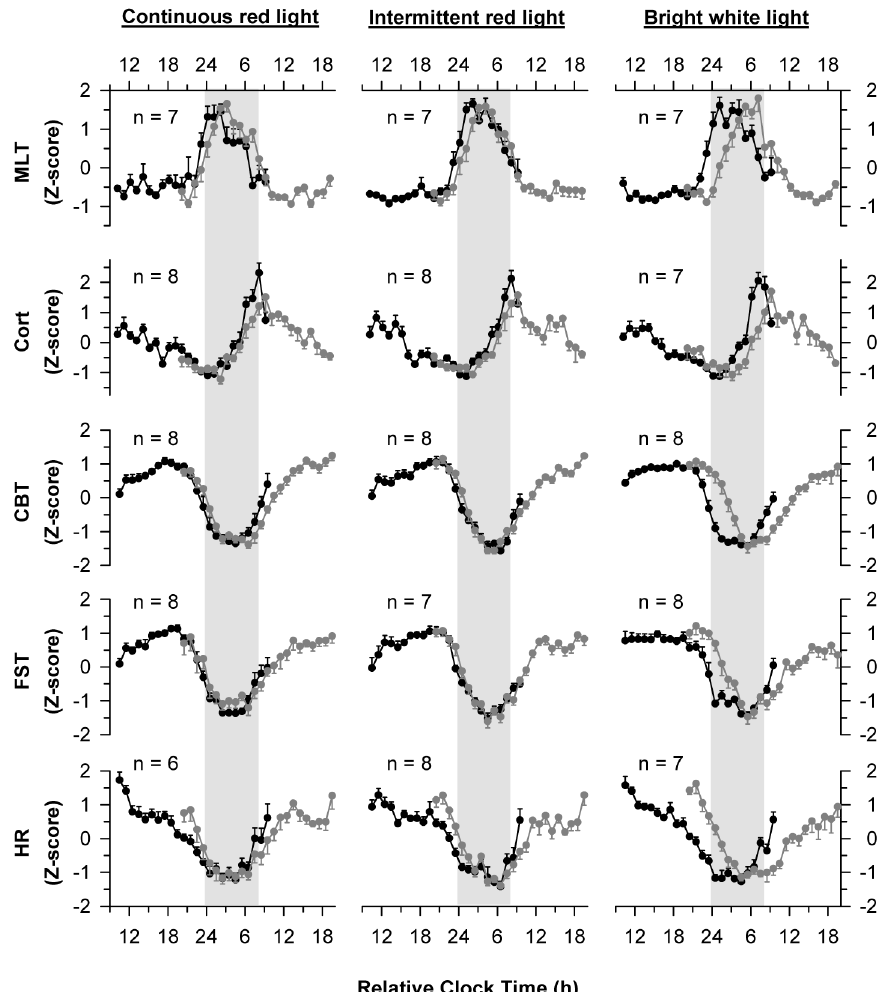
Figure 2. Circadian rhythms assessed before and after exposure to light. Circadian rhythms of melatonin (MLT), cortisol (Cort), core body temperature (CBT), forehead skin temperature (FST), and heart rate (HR) were measured using constant routine procedures. Black traces show rhythms on the day prior to light exposure, and gray traces show rhythms on the day after light exposure. Subjects were exposed to 6 h of continuous red light (left column), intermittent red light and darkness (center column), or bright white light (right column) starting 1 h before habitual bedtime. Results are Z-scored and averaged across subjects with data binned hourly. Vertical gray bars indicate the usual hours of sleep. Since participants had different self-selected bedtimes prior to the study, and study events were timed according to each person’s pre-study sleep- wake schedule, analyses are presented using relative clock time, with relative bedtime defined as midnight. Circles with error bars show the mean 6 SEM. comparison, bright white light elicited an average phase shift of 2 2.64 h, equivalent to resetting the circadian system about 40 u of longitude in the westward direction. Although the magnitude of phase shift responses did not differ significantly across physiologic measures ( F 4,84.0 = 1.12; P = 0.35), there were large inter-individ- ual differences (Wald Z test of between-subject variance; z = 2.41, P = 0.016) in phase shift responses (Fig. 3A). Based on the average phase shift response across all available circadian rhythm markers, 6 out of 16 participants exposed to red light showed phase delay shifts greater than an hour (continuous, n= 4; intermittent, n =2).